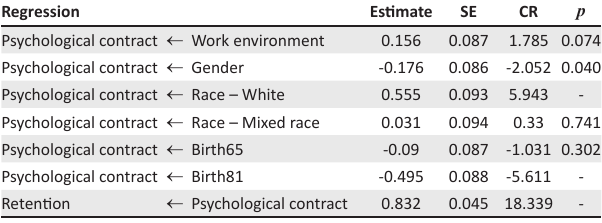
TABLE 3: Regression weights.